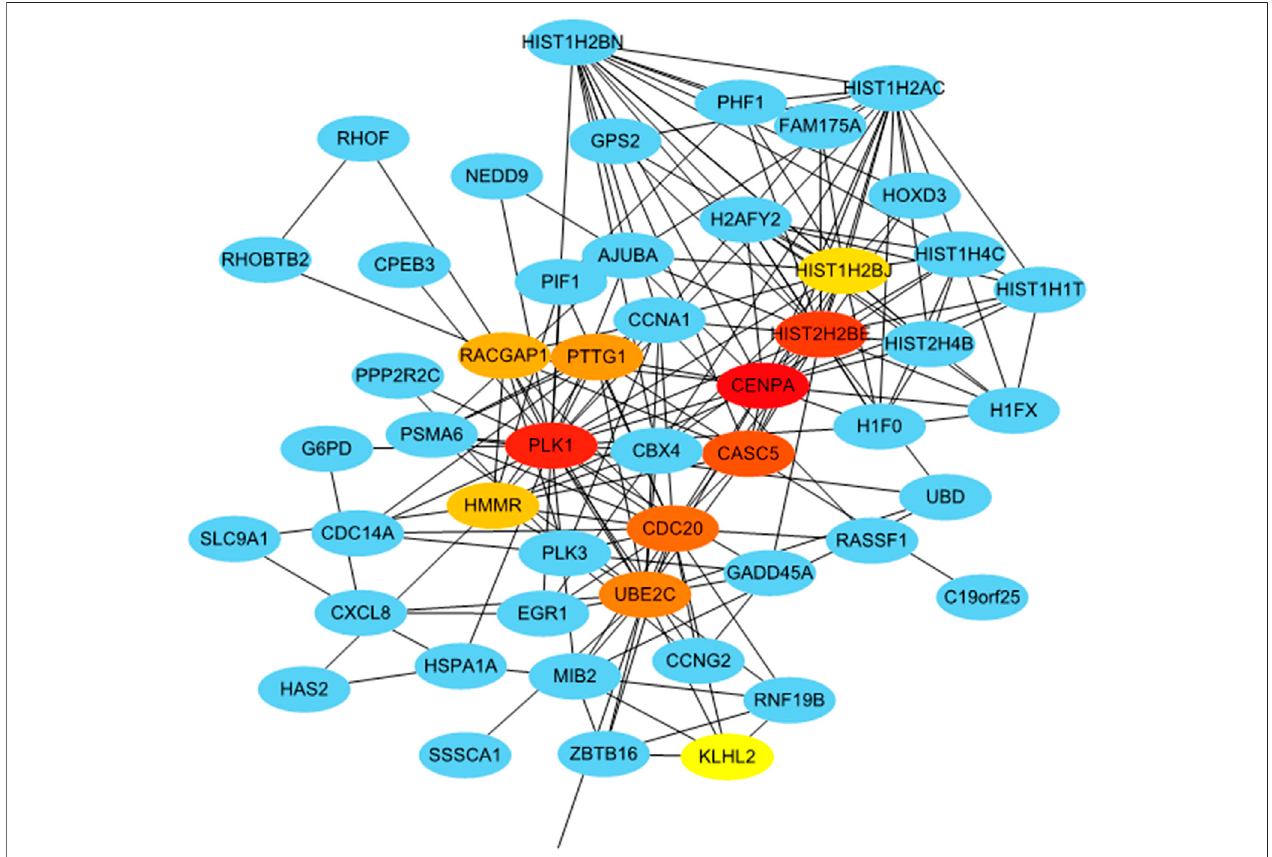
FIGURE 8 | Identi fi cation of hub genes from the PPI network with the CytoHubba. Top ten hub genes were ranked by MCC score.